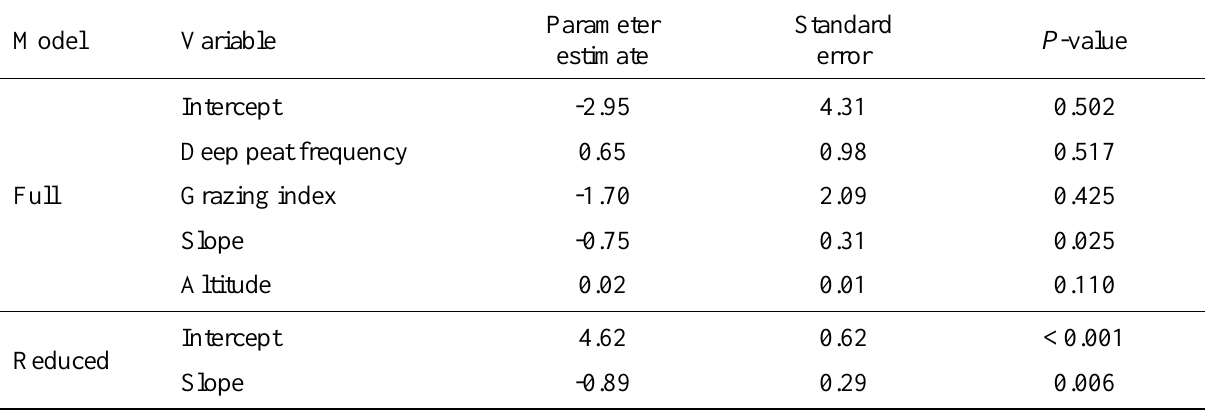
Table 2. Statistical analysis of the correlates of bare peat cover. The y -variable was the linear cover of bare